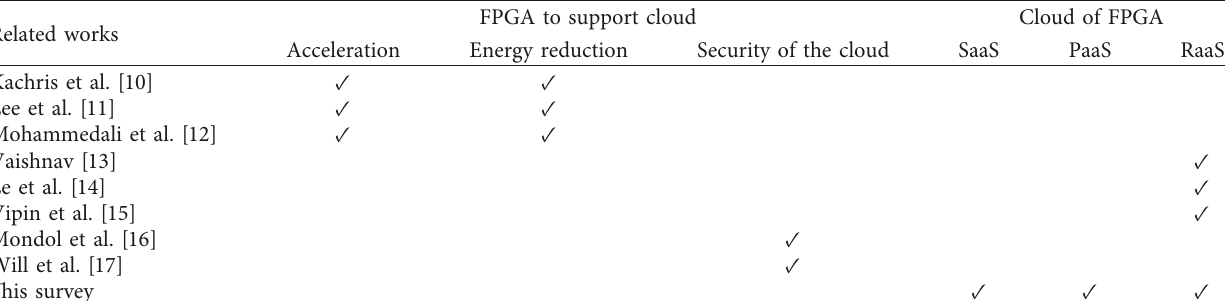
Table 1: Overview of several surveys introducing FPGA in